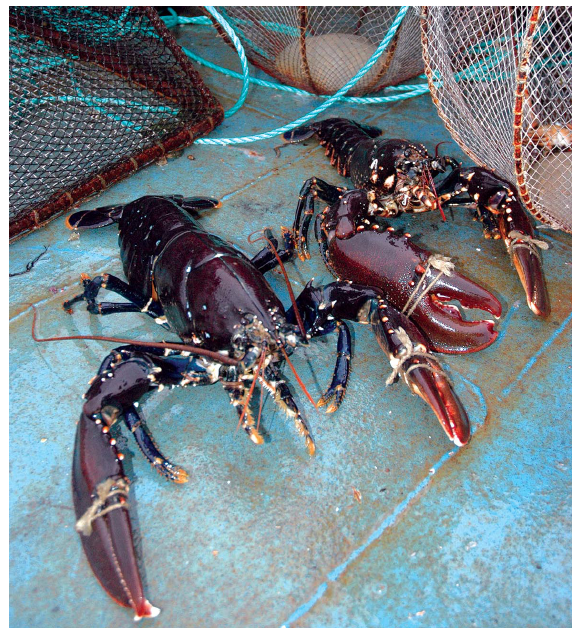
Figure 15: The cannibalistic lobster is particularly dif- ficult to breed. Photo: Frode